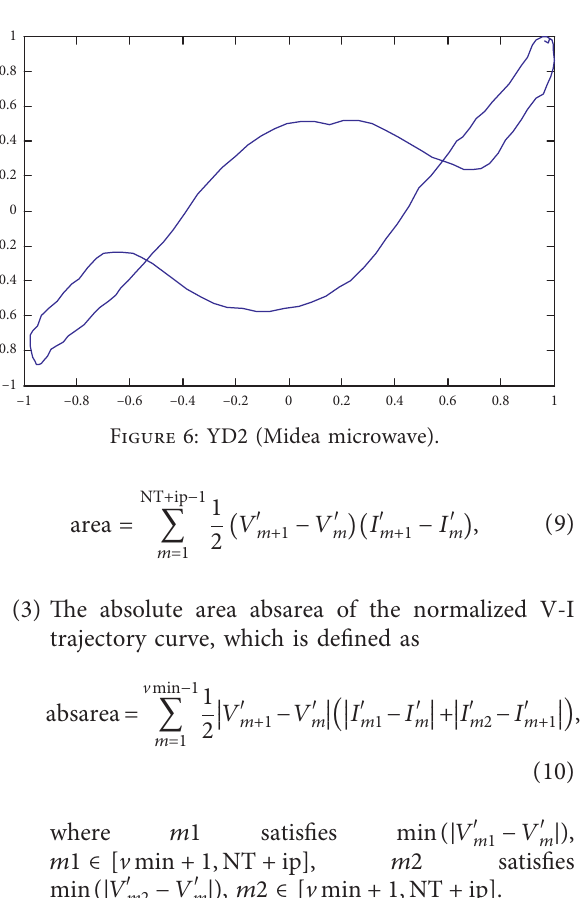
Figure 5: YD3 (Joyang hot pot).